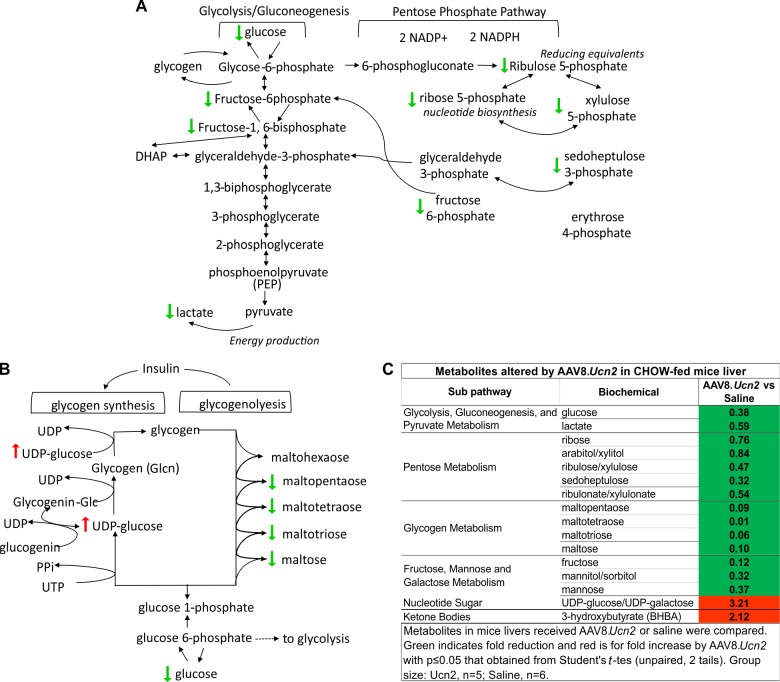
A. Diagram of glycolysis/gluconeogenesis and pentose phosphate pathways. Arrows indicate altered metabolites by AAV8.Ucn2 gene transfer. B. Diagram of glycogen synthesis and glycogenolysis pathways. Arrows indicate altered metabolites by AAV8.Ucn2 gene transfer. C. Metabolites altered by AAV8.Ucn2 in CHOW-fed mic liver. Metabolites in mice livers received AAV8.Ucn2 or saline were compared. Green indicates fold reduction and red is for fold increase by AAV8.Ucn2 with p≤0.05 that were obtained from Student's t-tes (unpaired, 2 tails). Group size: Saline, n = 6; Ucn2, n = 5.